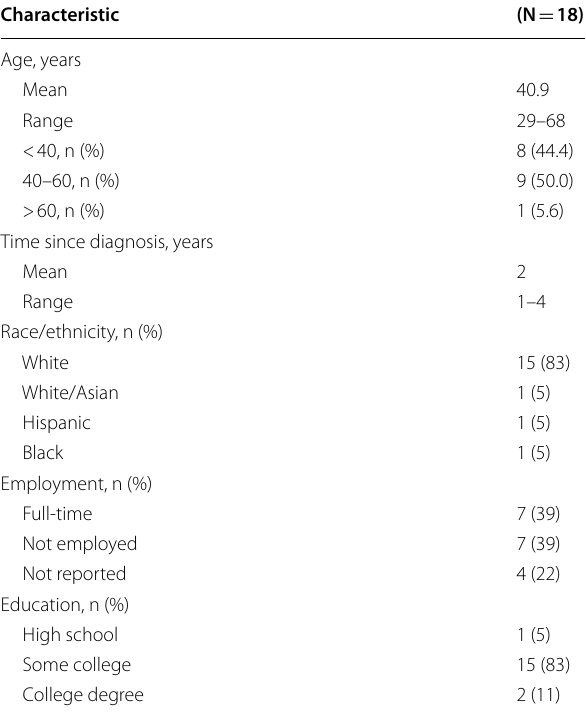
Table 1 Characteristics of